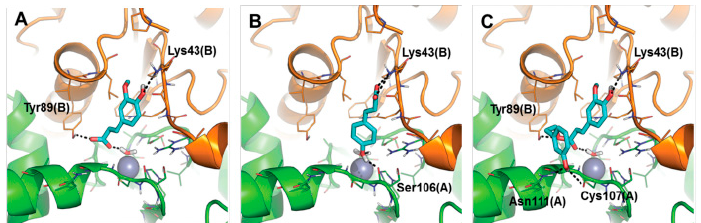
Figure 25. Predicted binding mode of 2 (panel A ), 3 (panel B ) and 8 (panel C ) towards the active site of Rv3588 β -CA from Mtb. Monomer A is colored green, monomer B is colored orange. Small molecules are shown as cyan sticks. Residues within 5 Å from the Zn(II) ion and those in contact with the inhibitors are shown as lines. H-bond interactions are highlighted by black dashed lines. Residues involved in H-bonds are labeled. The catalytic Zn(II) ion is shown as a grey sphere [85].